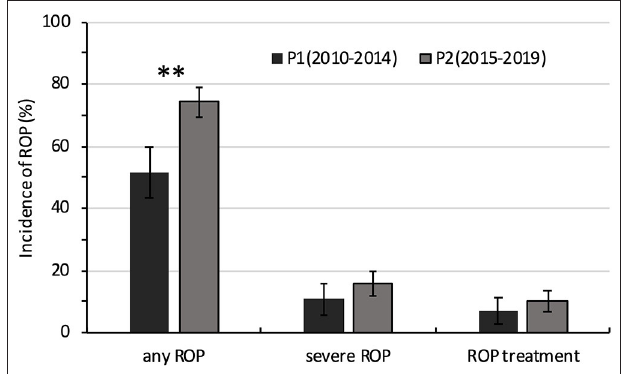
FIGURE 3 | Comparison of the incidence of ROP in extremely premature infants between 2010–2014 (P1) and 2015 − 2019 (P2). ** P <